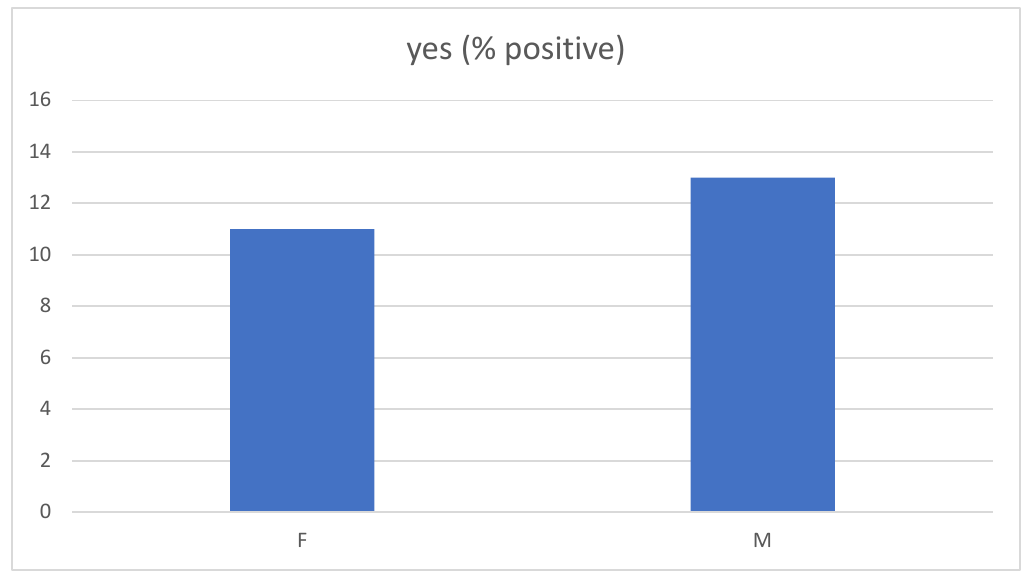
Figure 2. Dependence of positivity on birth weight ( p = 0.996).